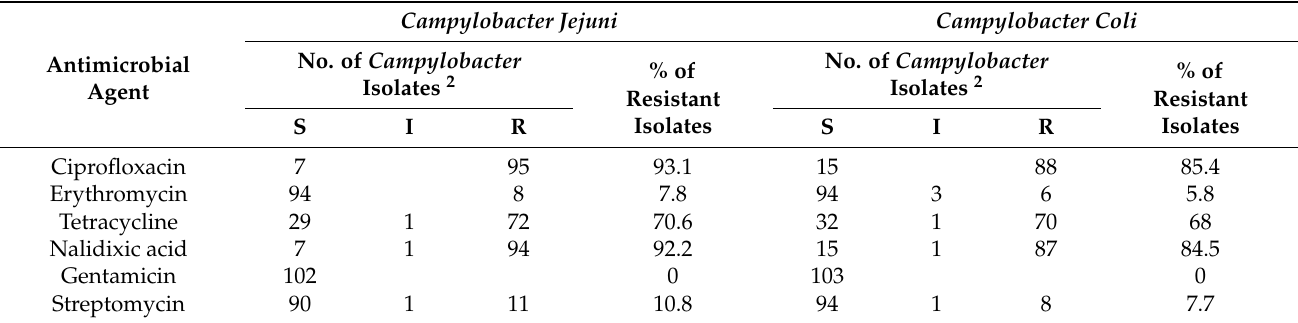
Table 3. Antimicrobial susceptibility patterns of Campylobacter isolates, identified by the disk diffusion method, according to the species 1